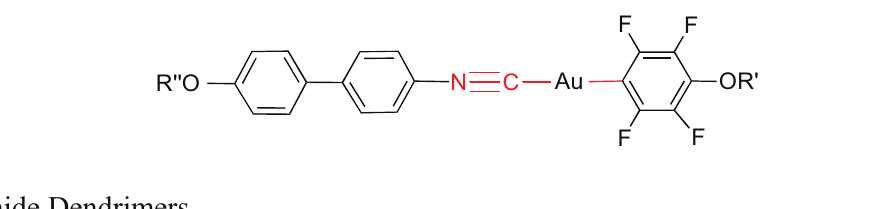
Figure 9. Three alkoxy chains cationic mesogens. X = PF